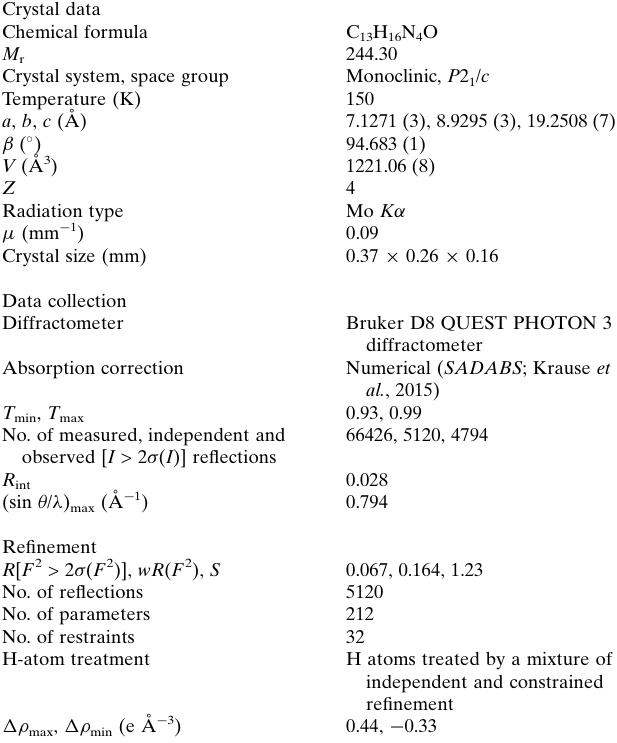
Table 4 Experimental details. Crystal data Chemical